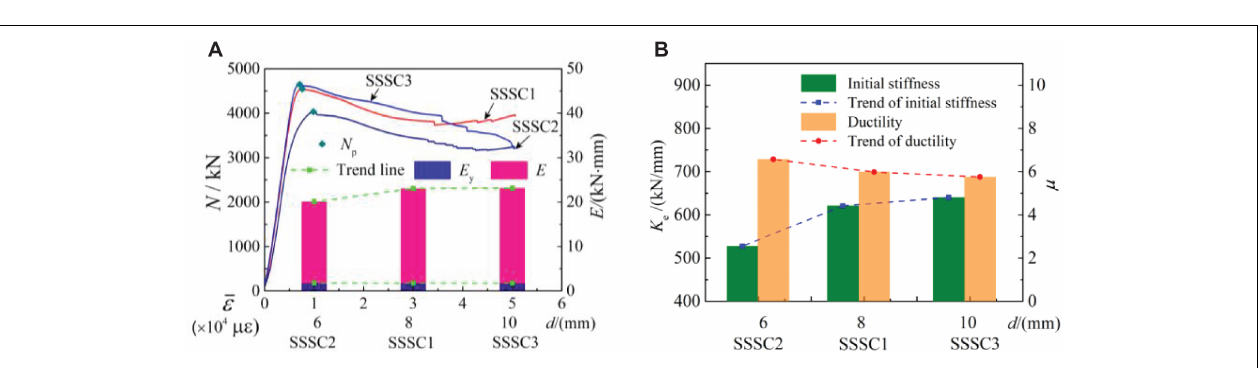
FIGURE 7 | Effect of diameter of stirrup. (A) Variation of peak load, strain, and energy dissipation. (B) Stiffness degradation and